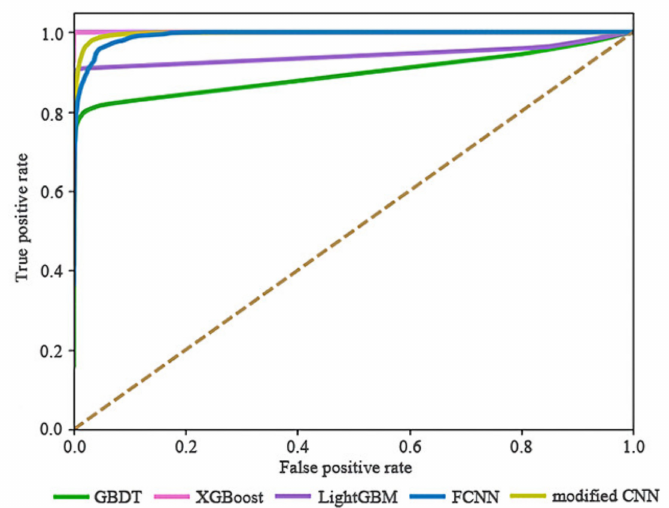
Figure 6. Receiver Operating Characteristic (ROC) curves of every classifier on the actual UAV flight